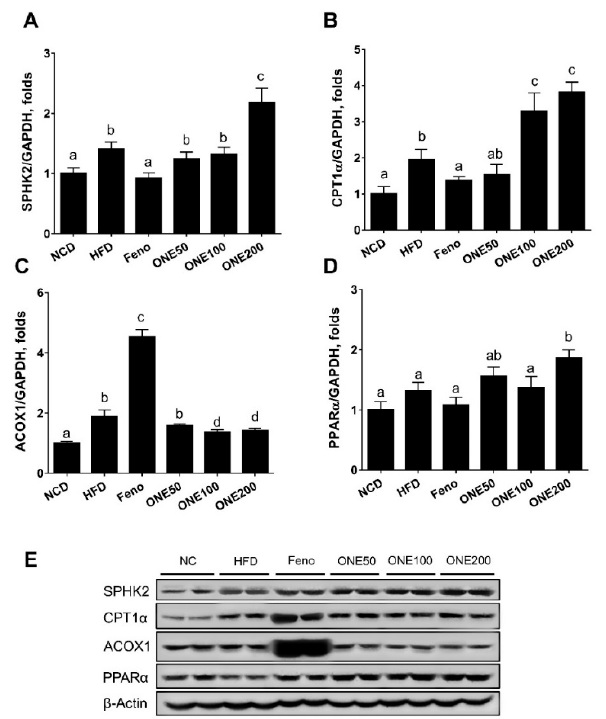
Figure 4. Upregulation of fatty acid oxidizing genes via sphingosine kinase 2 (SPHK2) activation in liver. After four weeks of co-feeding with ONE, mouse livers from six di ff erent treatment groups were collected and mRNA expression levels of ( A ) SPHK2, ( B ) carnitine palmitoyltransferase (CPT1 α ), ( C ) peroxisomal proliferator activated receptor α (PPAR α ), and ( D ) peroxisomal acyl-coenzyme oxidase 1 (ACOX1) were measured using qRT-PCR. Data are presented as mean ± SEM ( n = 7). Di ff erent letters indicate statistical significance among treatment groups. ( E ) Protein levels of SPHK2, CPT1 α , ACOX1, and PPAR α were determined by immunoblot analyses method.